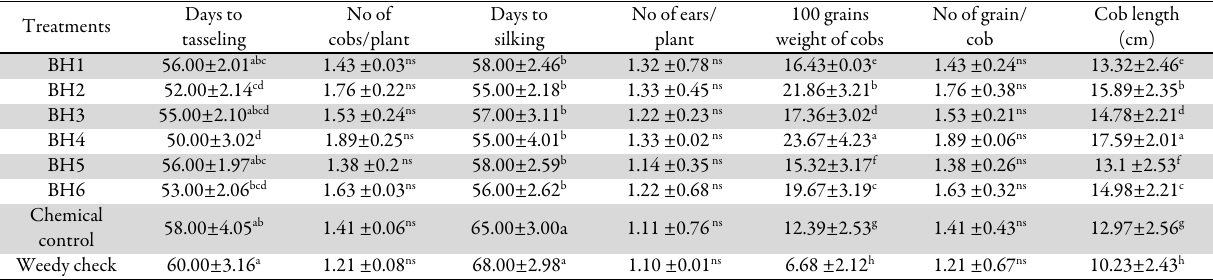
Table 5. The effect of various formulations from Lasiodiplodia psedotheobromae on yield component of maize Treatments